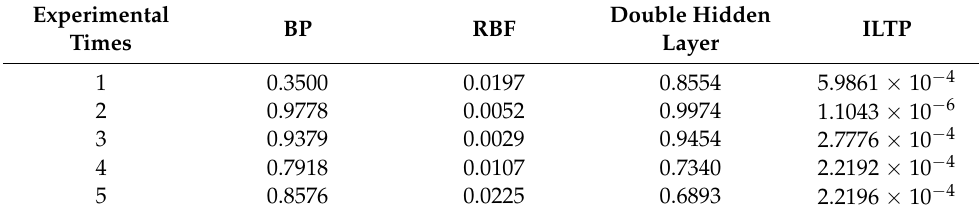
Table 3. Comparison results of maximum absolute